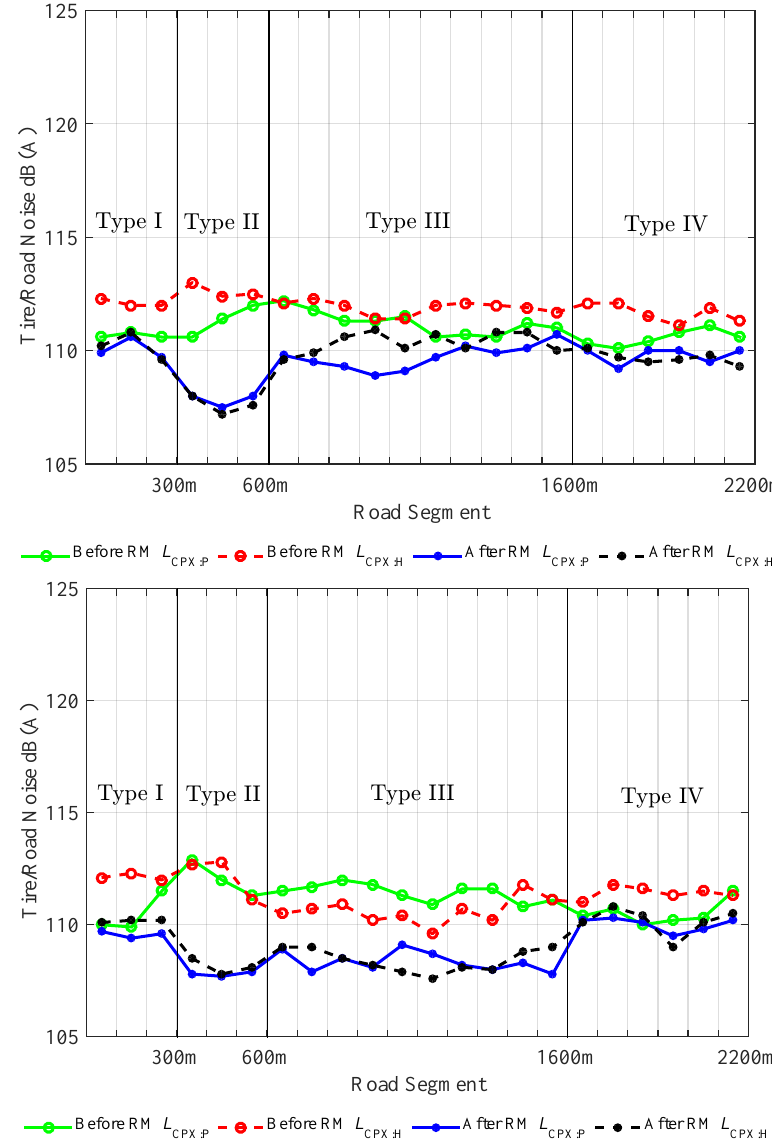
Figure 4. Tire/road noise equivalent sound pressure level at 60 km/h before and after road mainte- nance (RM): inner lane ( Upper ); outer lane ( Lower